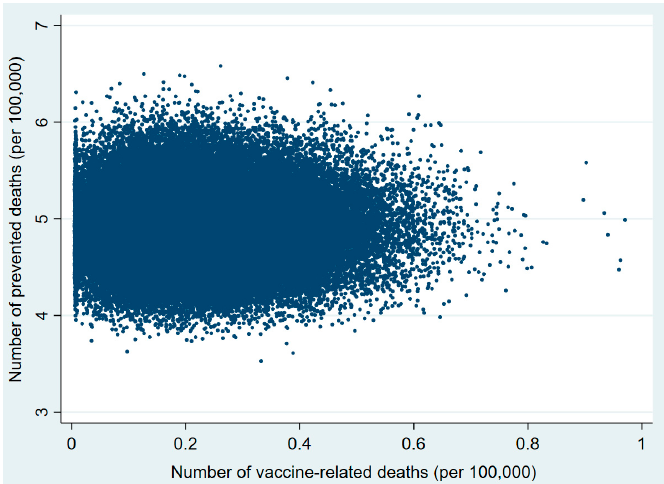
Figure 2. Probabilistic sensitivity analysis. Number of vaccine-prevented deaths for COVID-19 (benefit) vs. vaccine-related deaths for thrombo-embolic events risk) after 100,000 simulations. Individuals aged 30–49 years, Italy.